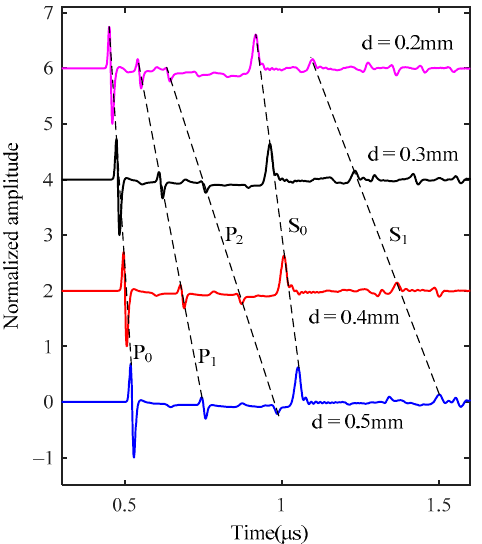
Figure 5. The normalized out-of-plane velocity curves. When the axis of the detection laser is not coincident with the z -axis (PRD ≠ 0), the propagation path of the ultrasonic wave changes, and the peak arrival time changes accordingly. The spot radius of the pulse laser beam affects the acoustic field distribution and the peak arrival time. In the model with a copper layer thickness of 0.5 mm, different pulse laser spot radii are used, and the values of the spot radii are 0.5 mm, 1 mm, and 1.5 mm, respectively. It can be seen from Figure 3b that, when the L is calculated by using simulation data, the T Δ in Equation (11) must be replaced by t Δ , as shown in Equation (12), and t Δ was determined to be 10 ns by simulation analysis.